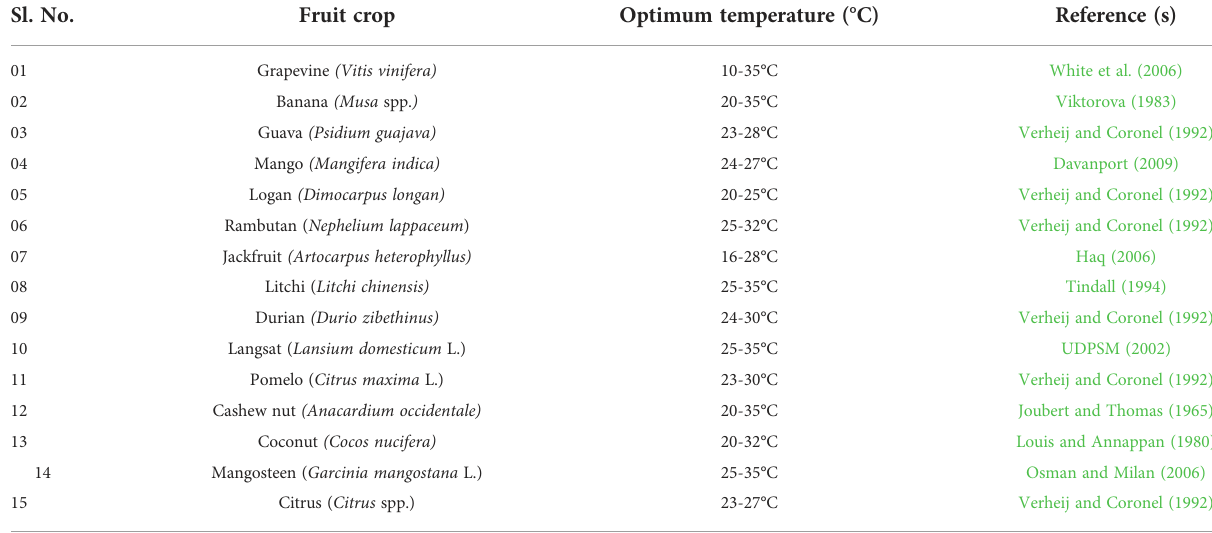
TABLE 1 Optimum temperature ranges for the growth of some tropical and subtropical fruit species. Sl.